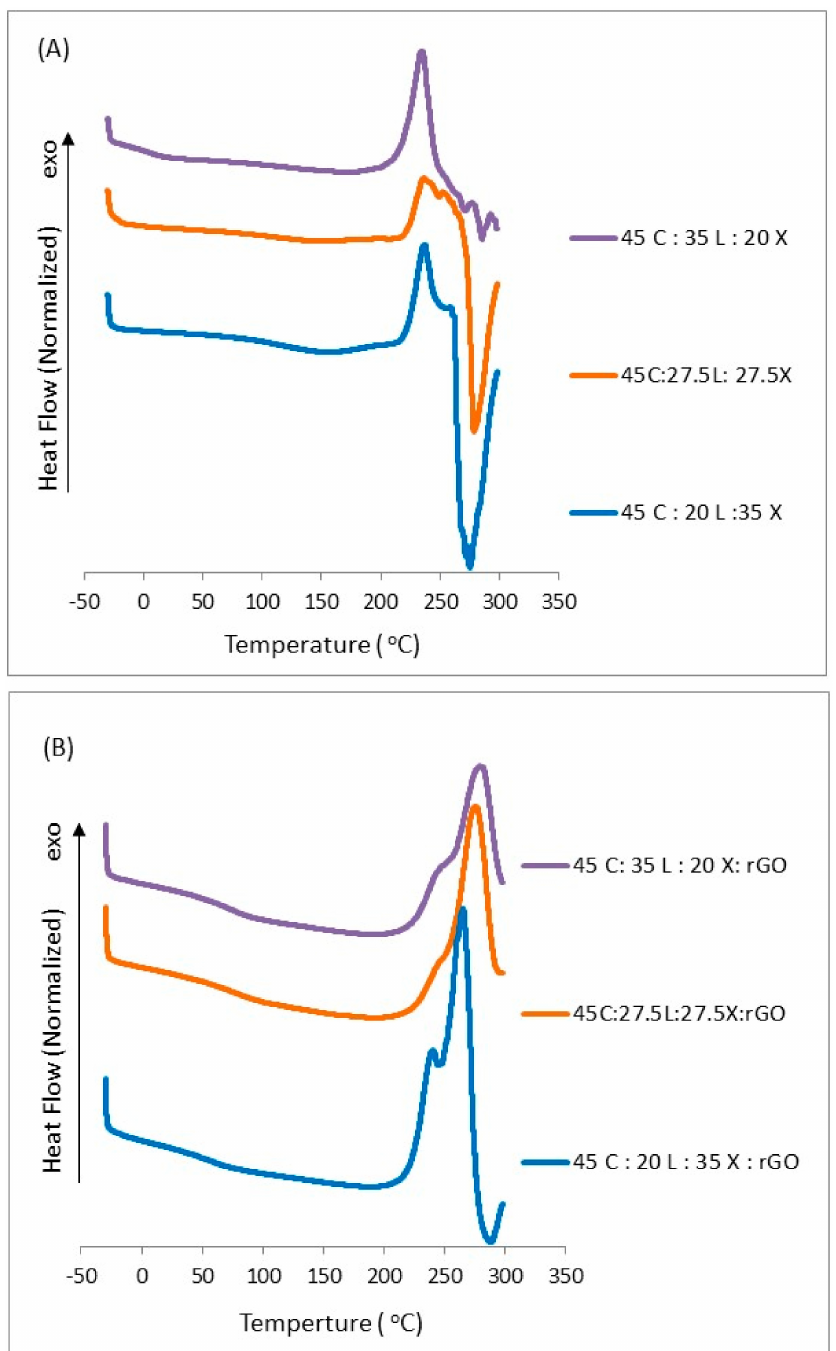
Figure 4. DSC curves of blended lignocellulosic films ( A ) without rGO and ( B ) with